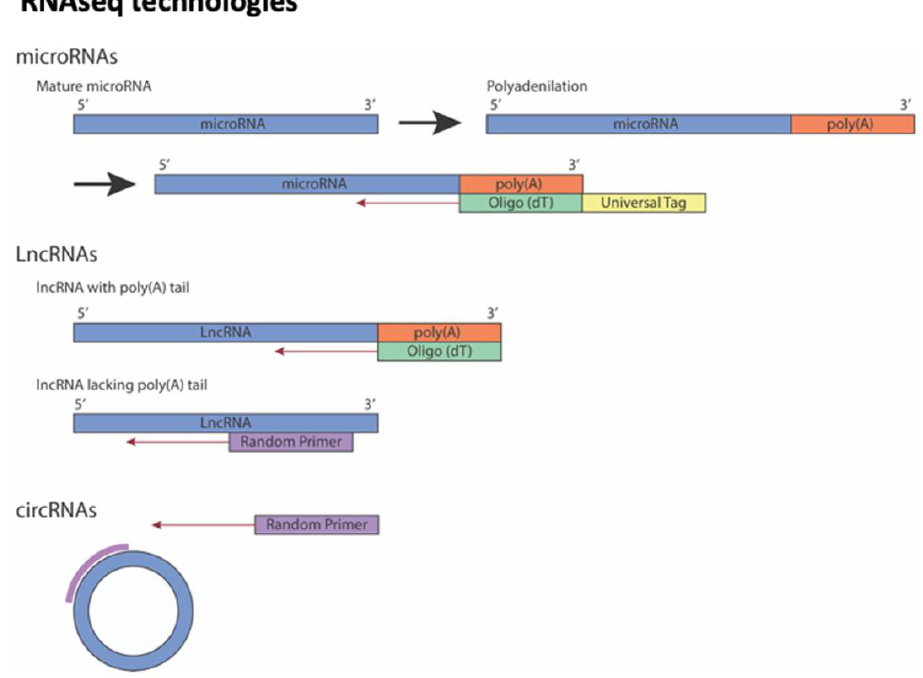
Figure 1. Overview of strategies to sequencing different non-coding RNAs. Note that lncRNAs could be sequencing using Oligo (dT) or Random Primer depending on whether poly(A)-tail on lncRNA is present or not.